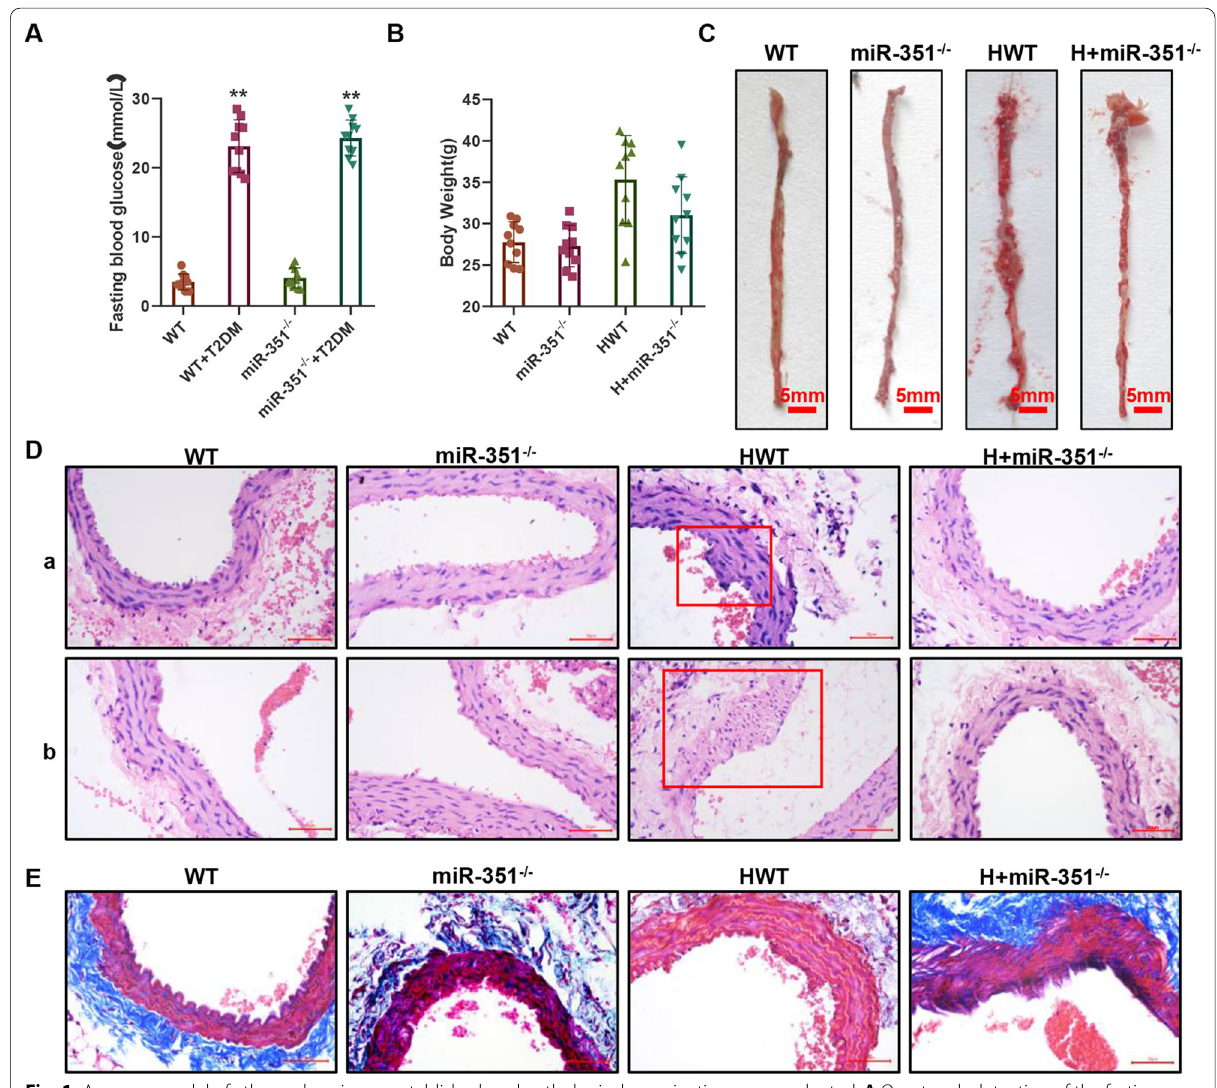
Fig. 1 A mouse model of atherosclerosis was established, and pathological examination was conducted. A One-touch detection of the fasting blood glucose FBG index in mice. N 10 mice per group. B Weight results of mice in each group. N 10 mice per group. C Oil red O was used = = to stain the aorta in the thoracic region of mice in each group, and red stain indicated the site of oil presence or plaque formation. D HE staining results: The vascular tissue of the abdominal aorta is shown in the upper part, and the aortic arch is shown in the lower part. The scale bar represents 50 μm. E Masson trichromatic staining was performed on collagen, with blue representing collagen parts and red representing muscle fibers and other tissues. The scale bar represents 50 μm. Histopathological test, N 3 mice per =